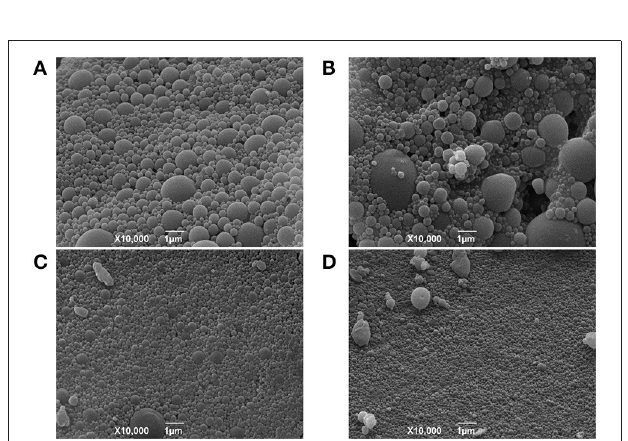
FIGURE 2 | Morphological characterization of NP1 and NP2 by TEM. Transmission electron microscopy images of NP-Ø (A,C) and NP-17-DMAG (B,D) produced by P1 (A,B) or P2 (C,D) double emulsion protocols. 10 µ L of each sample was contrasted with 2% uranyl acetate for 2min in a formvar grid. Bars represent size references in µ m or nm.